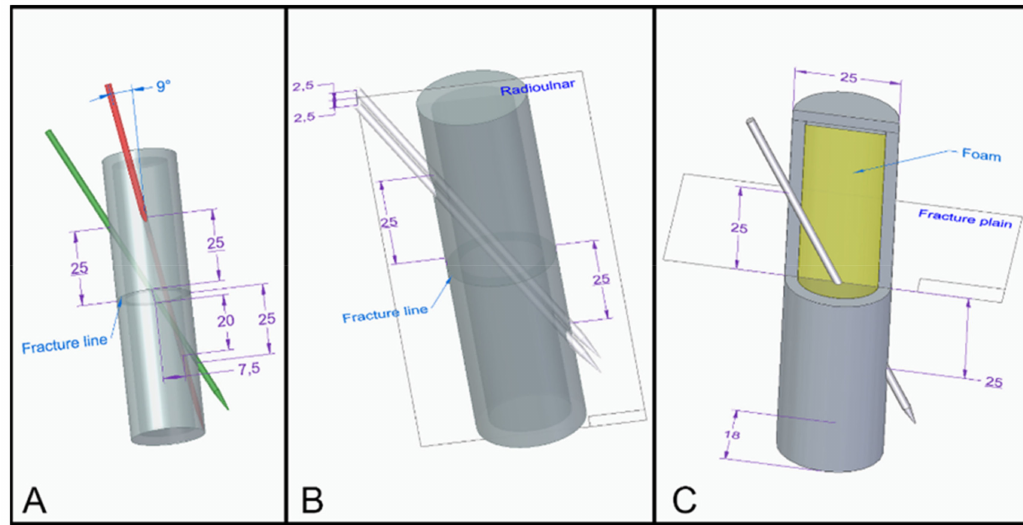
Figure 3. ( A ) Group I—crossed wires; ( B ) Group II—parallel wires; ( C ) Group III—single wire fixation. The purple arrows depict the location of the entry and the exit points of the wire and the diameters of the model. The blue arrows represent the angle between the wires at the crossed wires fixation. The black rectangles are characteristic of the various